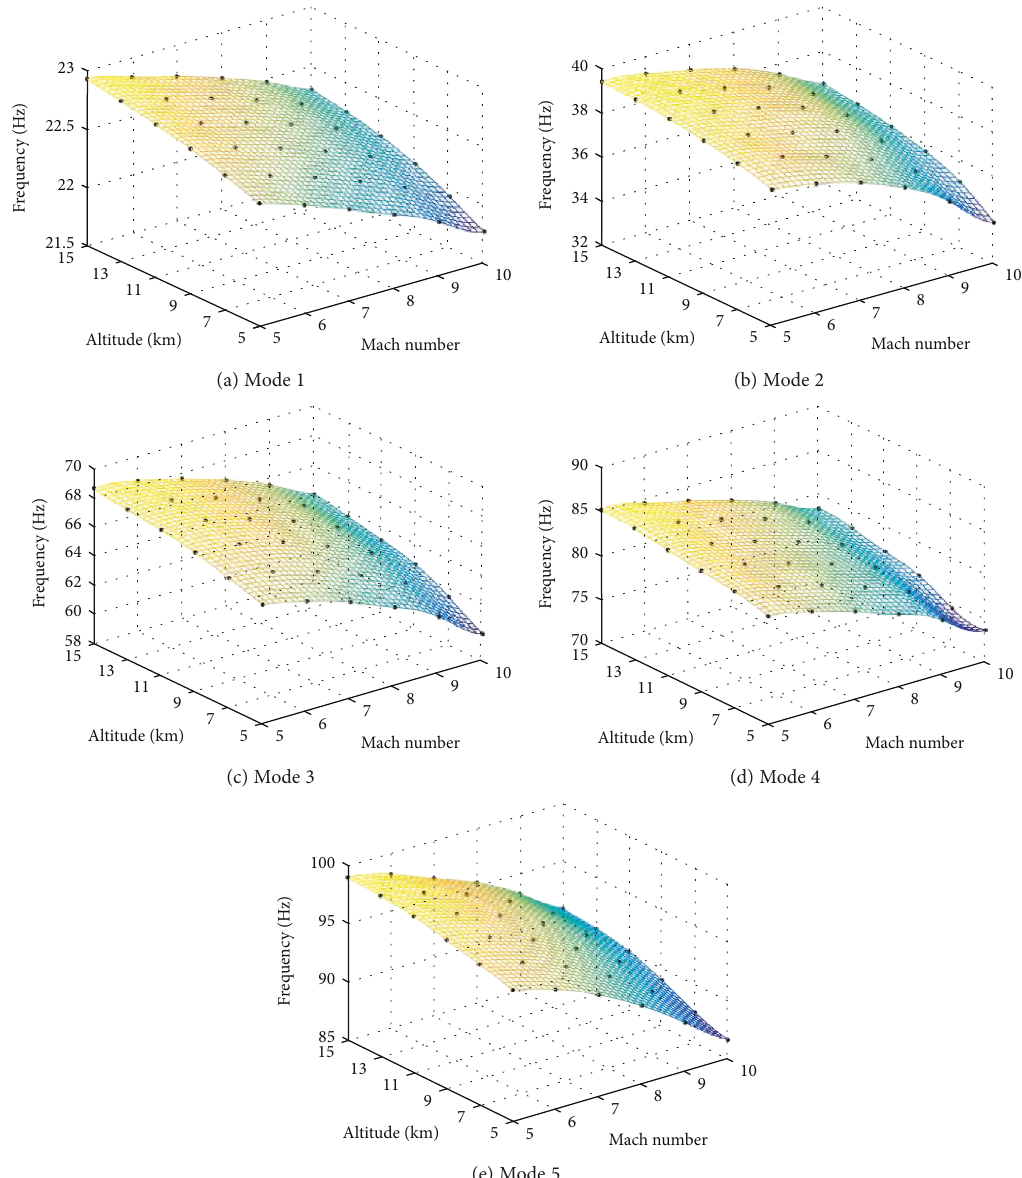
Figure 3: Kriging surfaces of modal